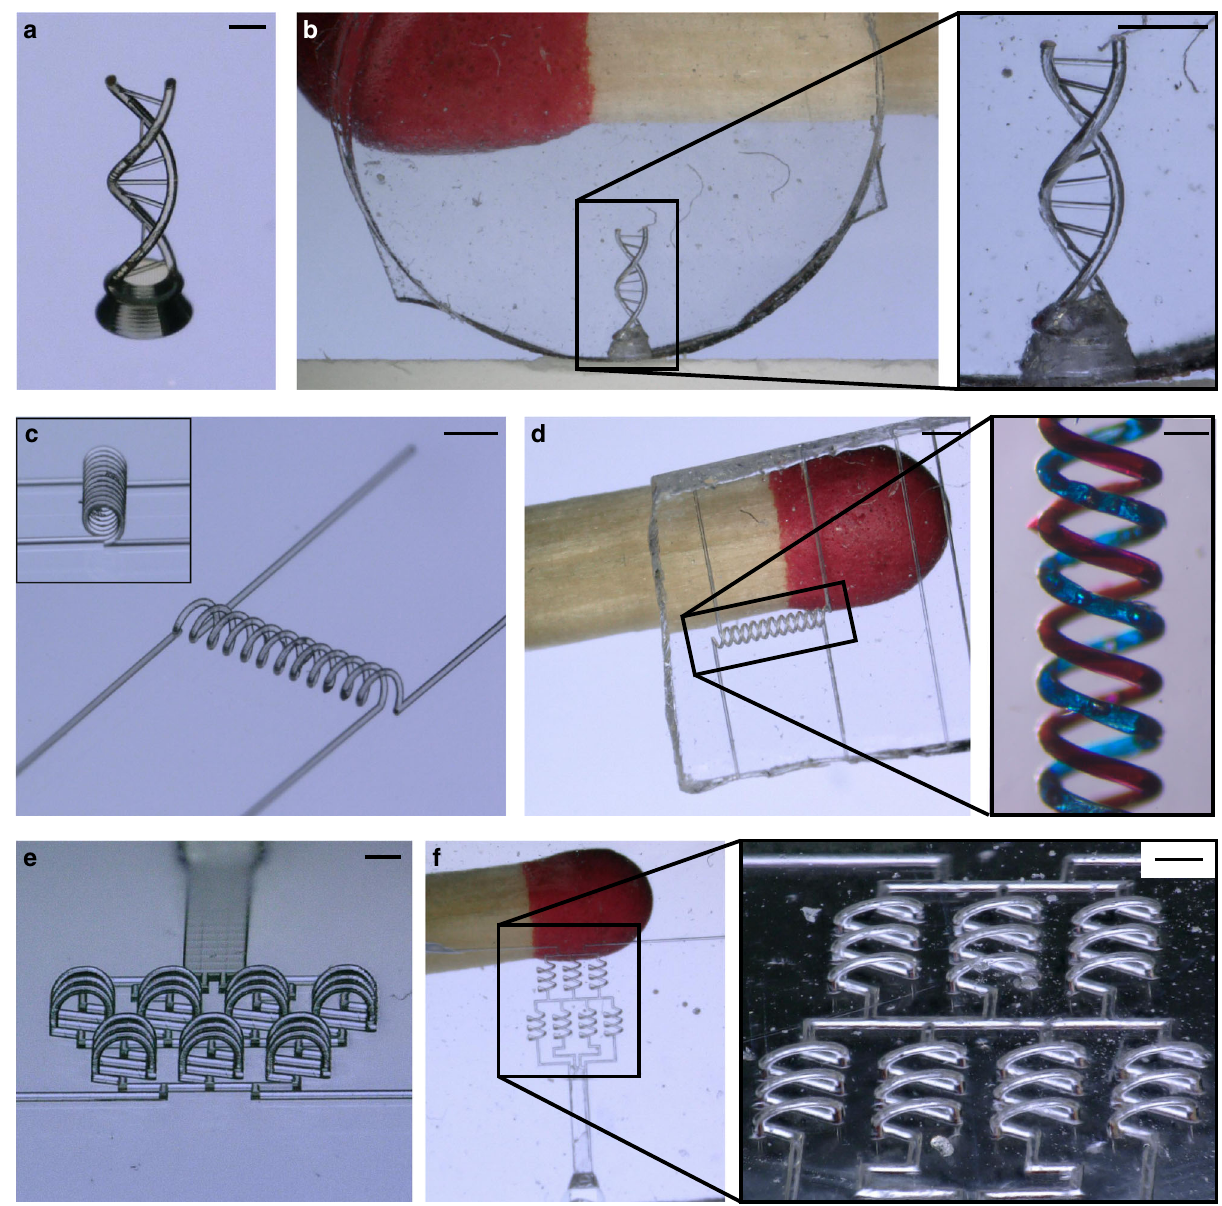
Fig. 2 STR using templates produced by direct laser writing. a Polymeric DNA double-helix (scale: 500 µ m). b Inverse structure in fused silica glass (scale: 400 µ m). The smallest channel size is 20 µ m. c Intertwined spirals (scale: 900 µ m). d Resulting intertwined micro fl uidic spiral channels in fused silica glass with a channel width of 74 µ m. The channels were fi lled with dyes (see inset, scale: 140 µ m). e Polymeric microstructures of an out-of-plane mixer structure (scale: 600 µ m). f Micro fl uidic mixer structure in fused silica glass with a channel width of 74 µ m (scale bar: 280 µ m). As can be seen the